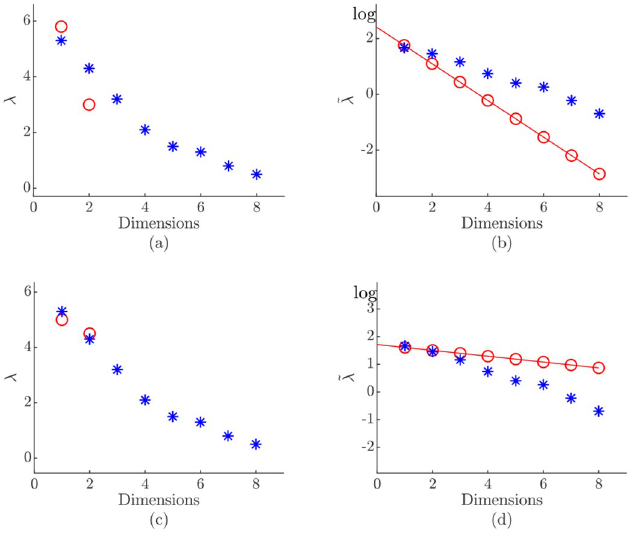
Fig 4. Occurrence of over- or underestimations due to not fully trained eigenvalues λ 1,2 . The real eigenvalues are represented by a star ( � ) and the estimations by circles (o): (a)-(b) shows an underestimation which results in a sharply declining line of best fit; (c)-(d) shows an overestimation which results in an almost flat line of best